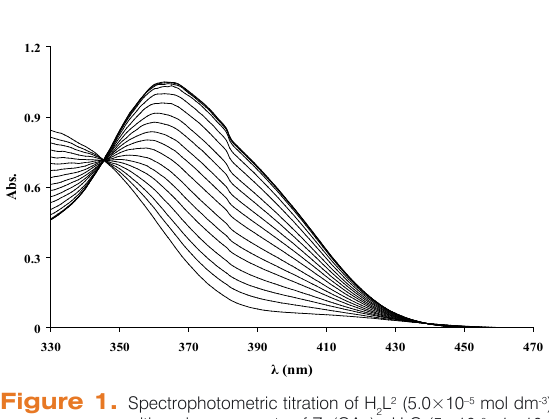
with various amounts of Zn(OAc) mol dm -3 ) in methanol, at I = 0.10 mol dm-3 (NaClO and at 25ºC.